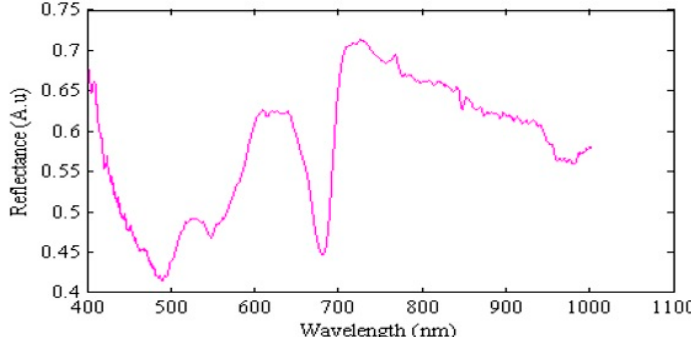
Figure 2. Mean reflection of the visible and near-infrared (VIS–NIR) spectrum for the obtained apple samples.